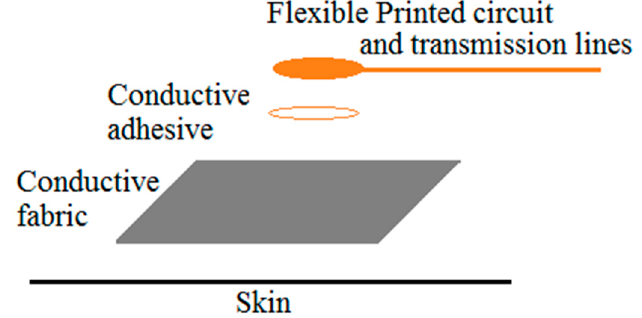
Figure 13. The layout of the hybrid textile electrode.